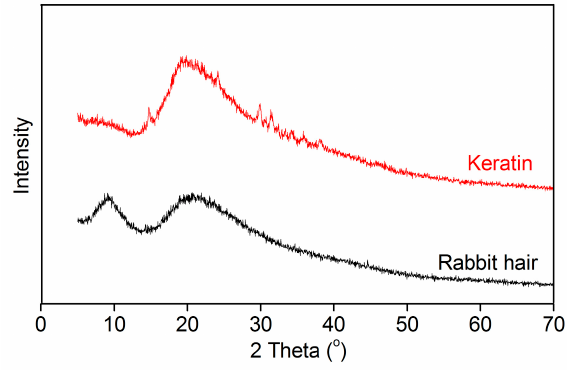
Figure 5. XRD patterns of rabbit hair and regenerated keratin by dissolving in DES at 120 °C.